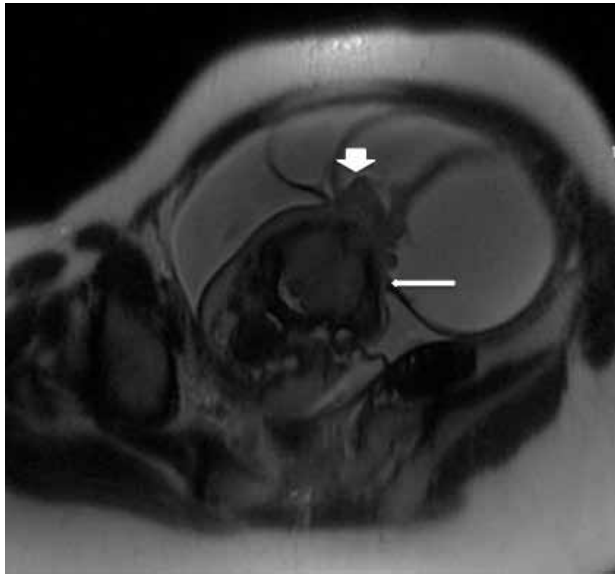
Fig. 2. Case 2: Axial fetal MRI: An occipital defect(long arrow) with large encephalocoele containing cerebellar tissue (arrow head) is demonstrated.